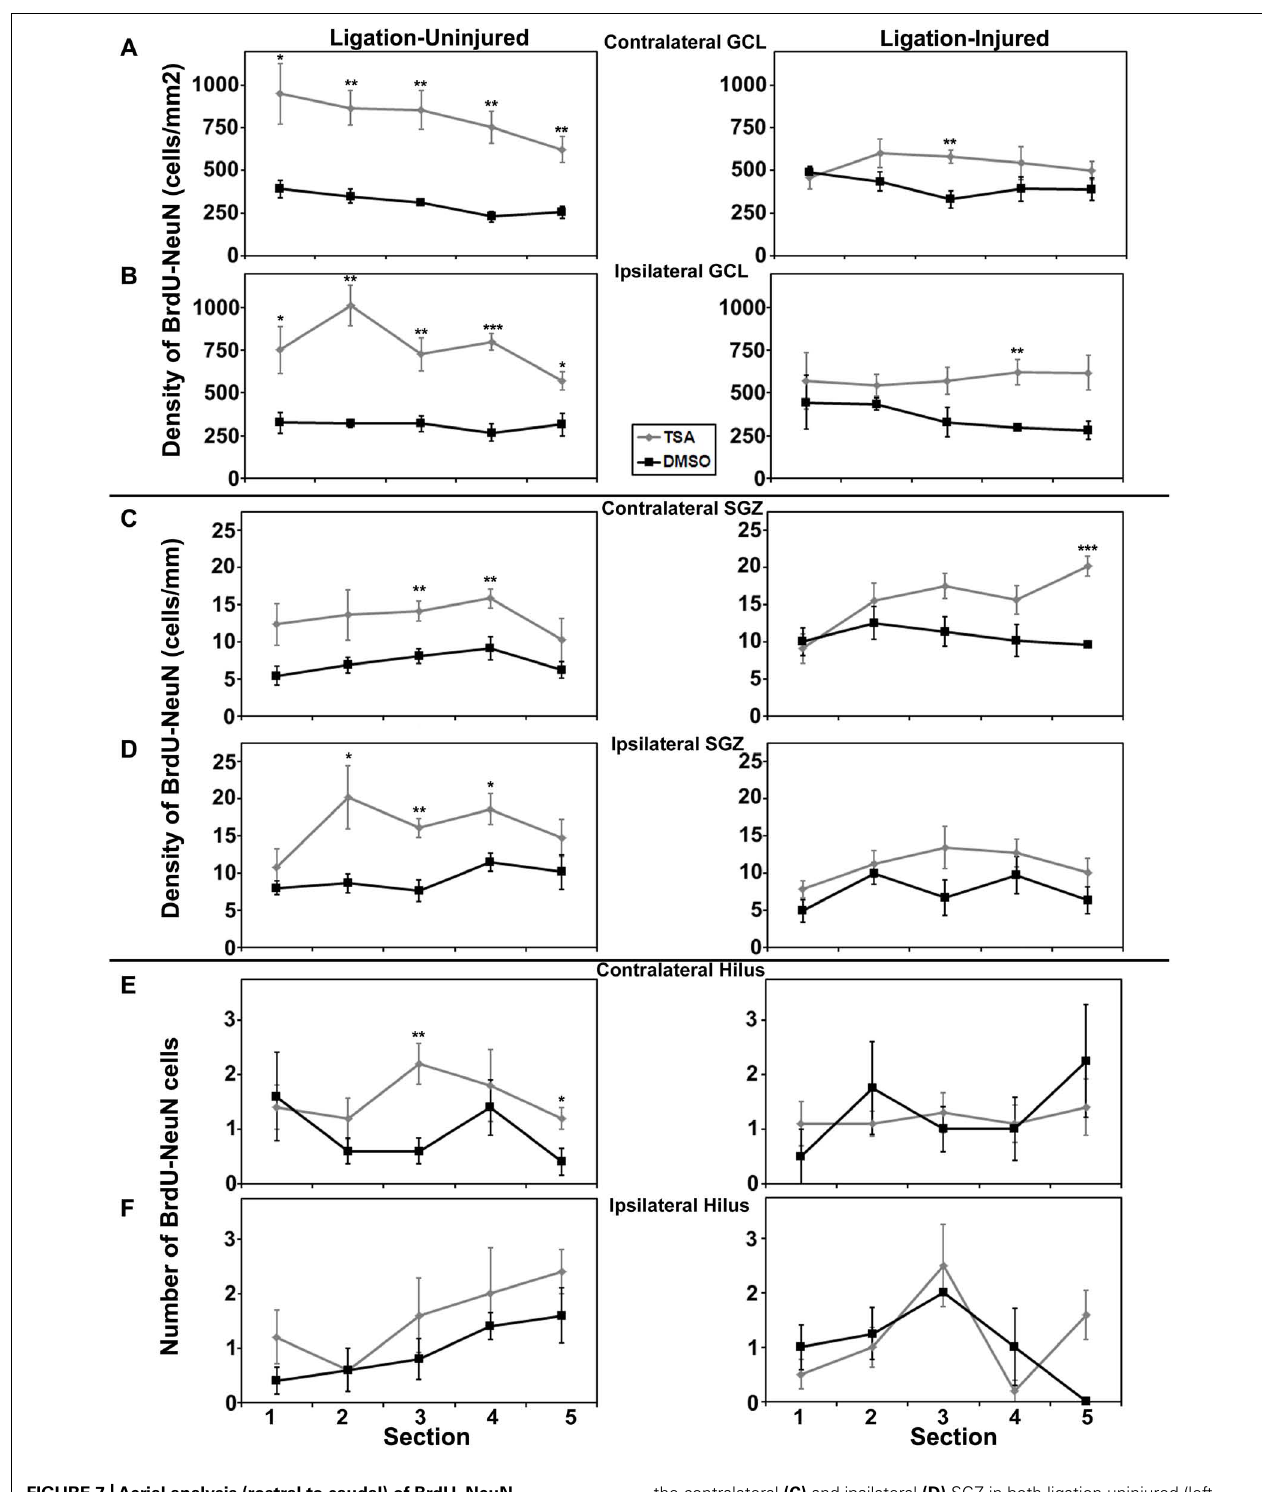
FIGURE 7 |Aerial analysis (rostral to caudal) of BrdU–NeuN density (A–D) or counts (E,F) in mice treated withTSA or DMSO in Protocol 2. (A,B) Average densities of BrdU + /NeuN + within the contralateral (A) and ipsilateral (B) GCL in both ligation-uninjured (left panel) and ligation-injured (right panel) mice treated withTSA or DMSO. (C,D) Average densities of BrdU + /NeuN + cells along